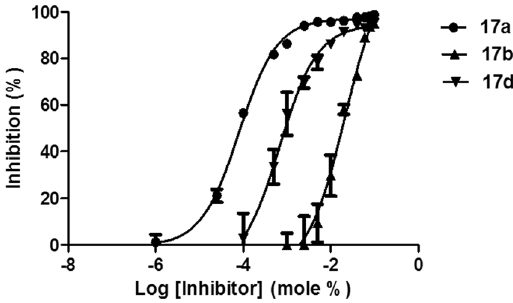
Figure 6. Inhibition curves for 17a , 17b and 17d . The curves were generated using GraphPad Prism with a nonlinear regression targeted at symmetrical sigmoidal curves based on plots of % inhibition versus log(inhibitor concentration). The reported X I (50) values were calculated from the resultant